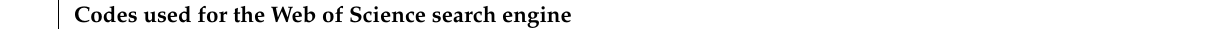
Codes used for the Web of Science search engine TS = (“green roof*” OR “green rooftop*” OR “wetland roof*” OR “roof garden*” OR “rooftop garden*” OR “vertical greenery systems” OR “green wall*” OR “living wall*” OR “green façade*” OR “vegetation screen*” OR “green curtain*” OR “vegetation curtain*” OR “urban garden*” OR “community garden*” OR “garden farm*” OR “garden bed*” OR “planter box*” OR “urban farm*” OR “urban farming” OR “urban agricultures” OR “hydroponics*” OR “aquaponics*”) AND TS = (“thermal comfort” OR “thermal stress” OR “thermal performance” OR “urban heat” OR “heat island” OR “cooling effect” OR “surface temperature” OR “air temperature”) AND TS = (“energy consumption” OR “energy saving” OR “energy demand” OR “energy balance” OR “energy efficiency” OR “energy usage” OR “electricity” OR “power”)